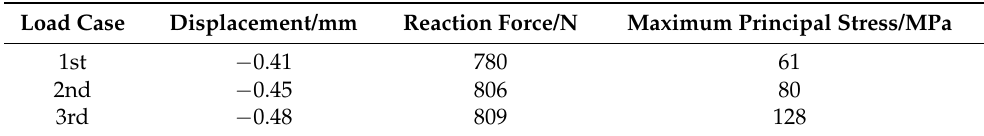
Table 1. The displacement, reaction forces and respective maximum principal stresses used in the